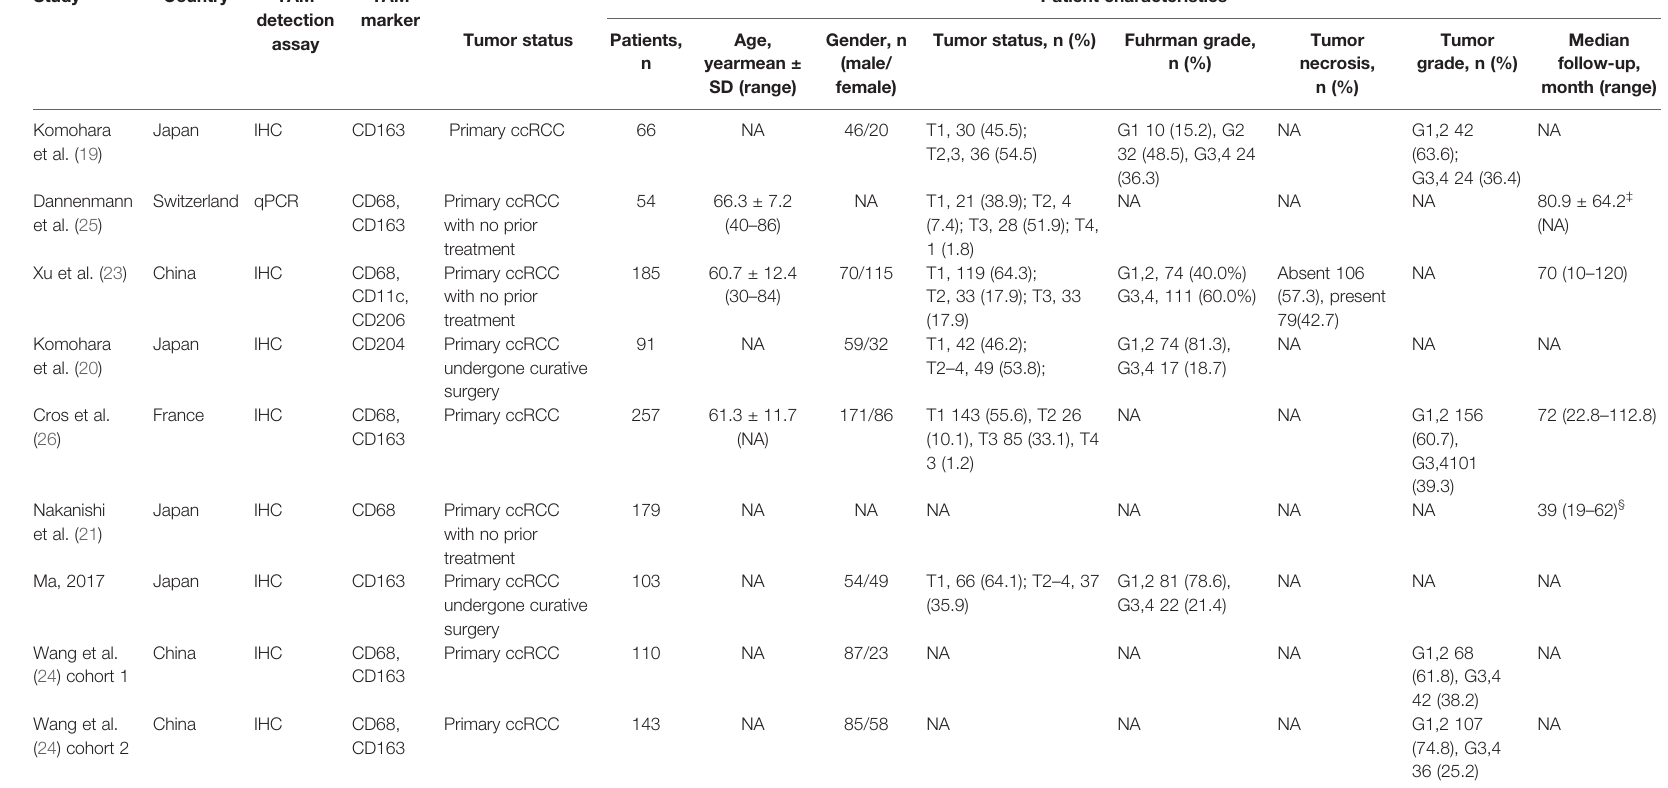
TABLE 1 | Characteristics of studies included in the